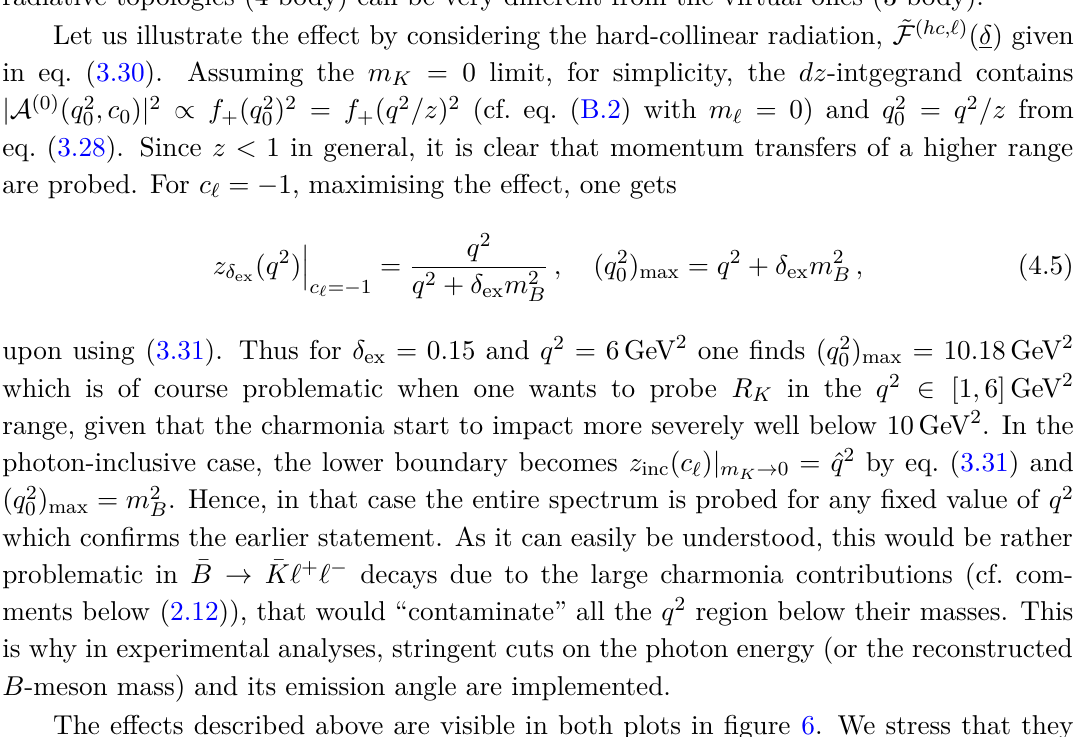
Figure 5 . Total relative QED-corrections (4.4) in terms of c 0 = cos( θ 0 ) c ‘ = cos( θ ‘ ) respectively for the electrically neutral hadron case. In the c 0 -variable effects are small for δ ex = δ inc comments in text and previous figures. The enhanced effect towards the endpoints {− 1 , 1 } in the electron case is, partly, due to the special behaviour of the LO expression (B.2) which behaves like ∝ (1 − c 2 ) + O ( m 2 ) and explains why the effect is less pronounced for ‘ ‘